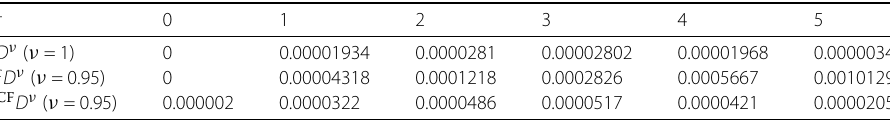
Table 2 Results of three types of derivative: ordinary derivative D ν , Caputo fractional derivative c D ν , and Caputo–Fabrizio fractional derivative CF D ν for U ( t )